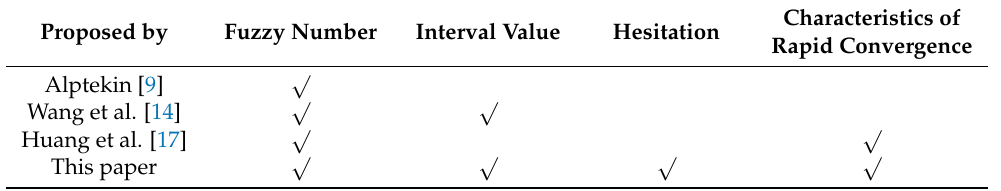
Table 11. Comparative analysis with other approaches. Proposed